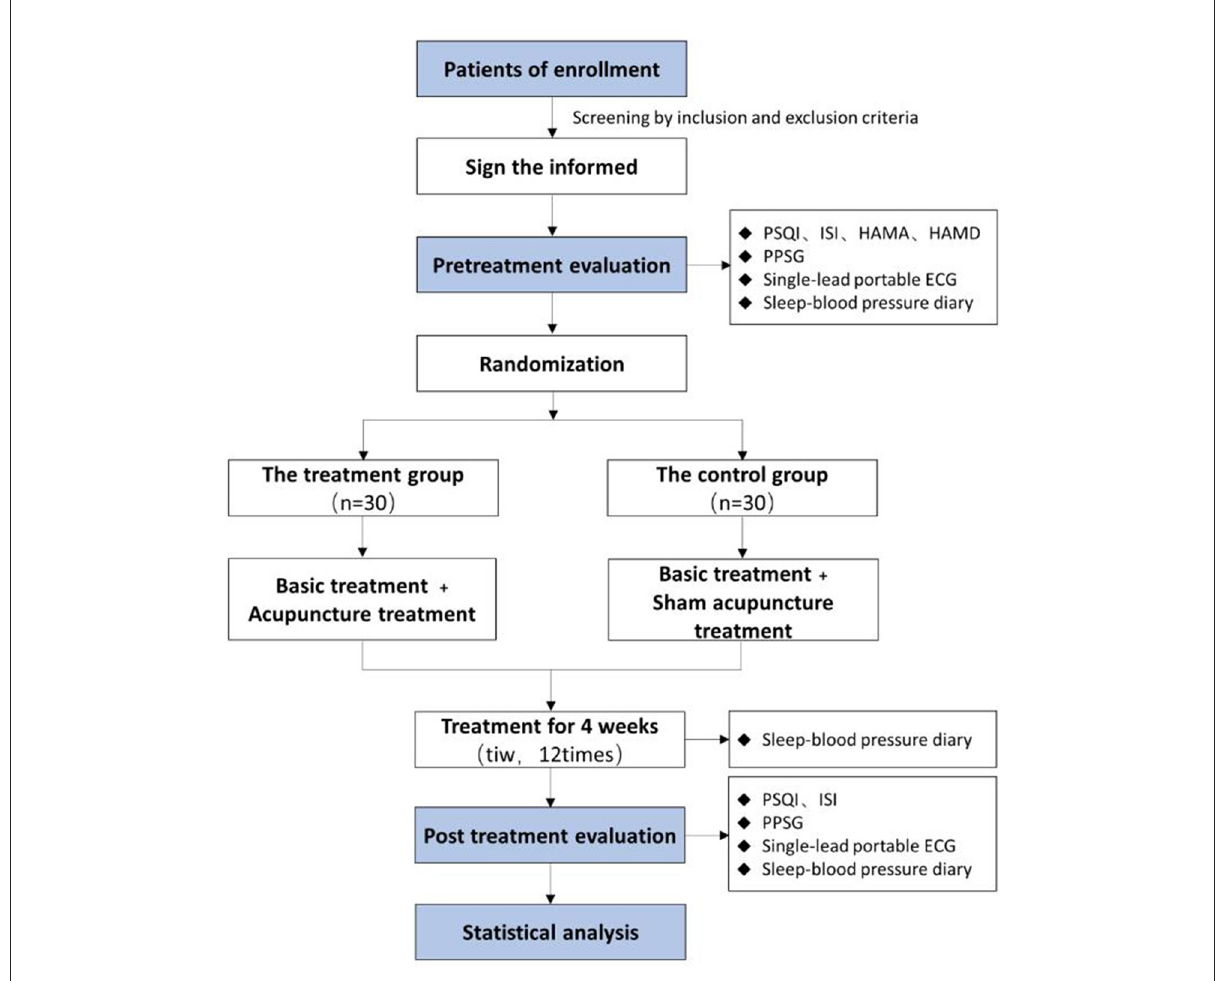
FIGURE1 Flow diagram of the